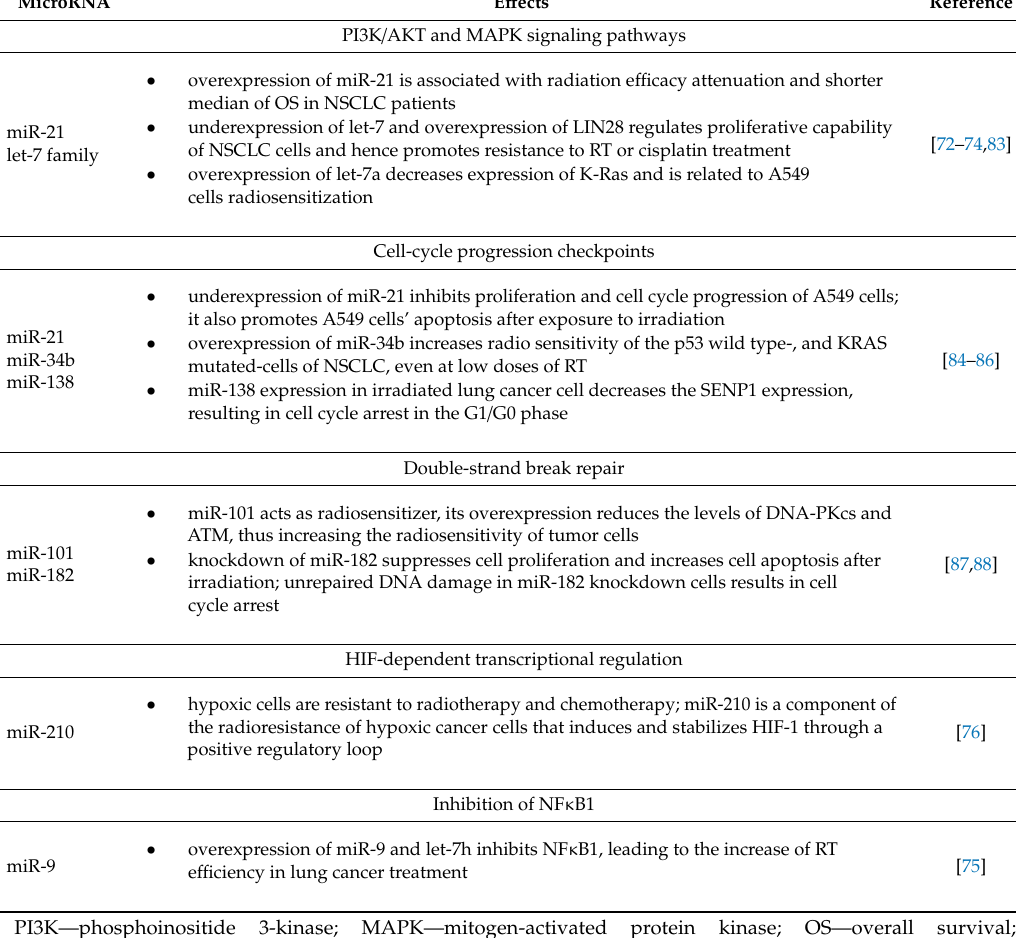
Table 3. Pathways and mechanisms of response to radiation damage regulated by